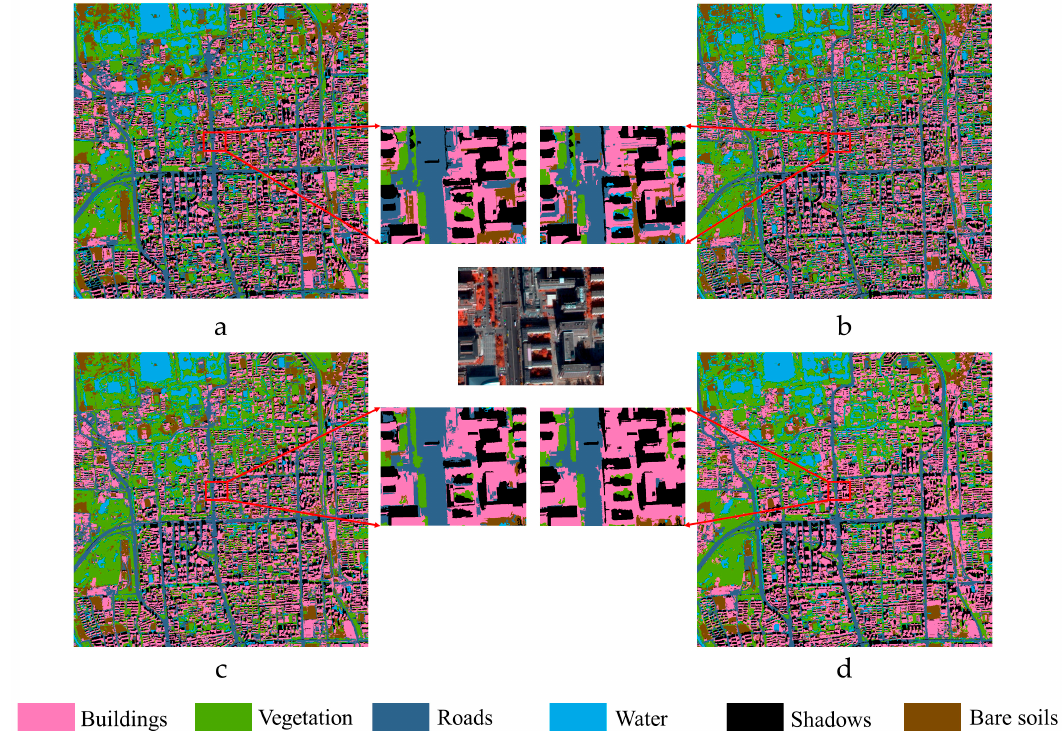
Figure 23. Classification results comparison of ( a ) Fu et al., ( b ) Zhao et al., ( c ) Zhang et al. and ( d ) our method on Beijing dataset.